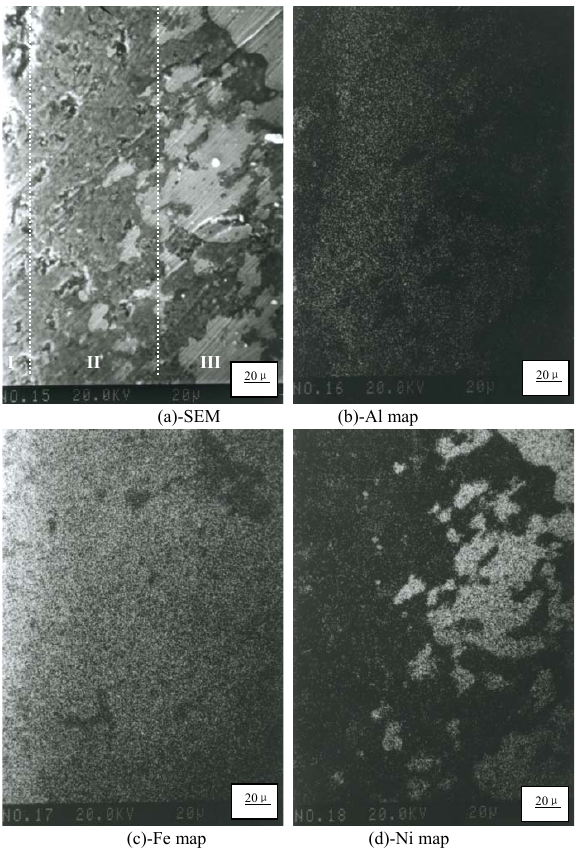
Figure 5. Microstructure of the 51Fe-39Ni-10Al 2 O 3 anode cross